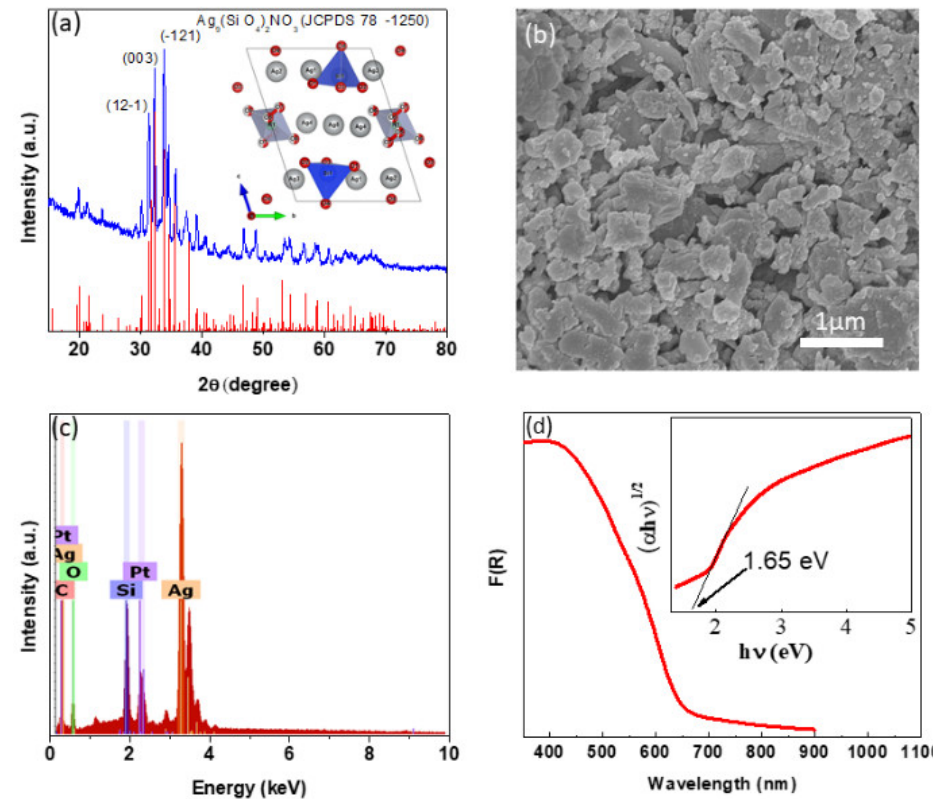
Figure 1. ( a ) XRD pattern and visual crystal structure of Ag 9 (SiO 4 ) 2 NO 3 . ( b ) FE-SEM image. ( c ) EDX element percentage of Ag 9 (SiO 4 ) 2 NO 3 . ( d ) UV–Vis spectra and inset band-gap measurement of Ag 9 (SiO 4 ) 2 NO 3 .